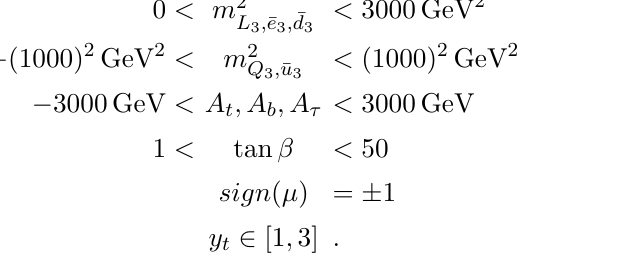
JHEP08(2019)105 H u